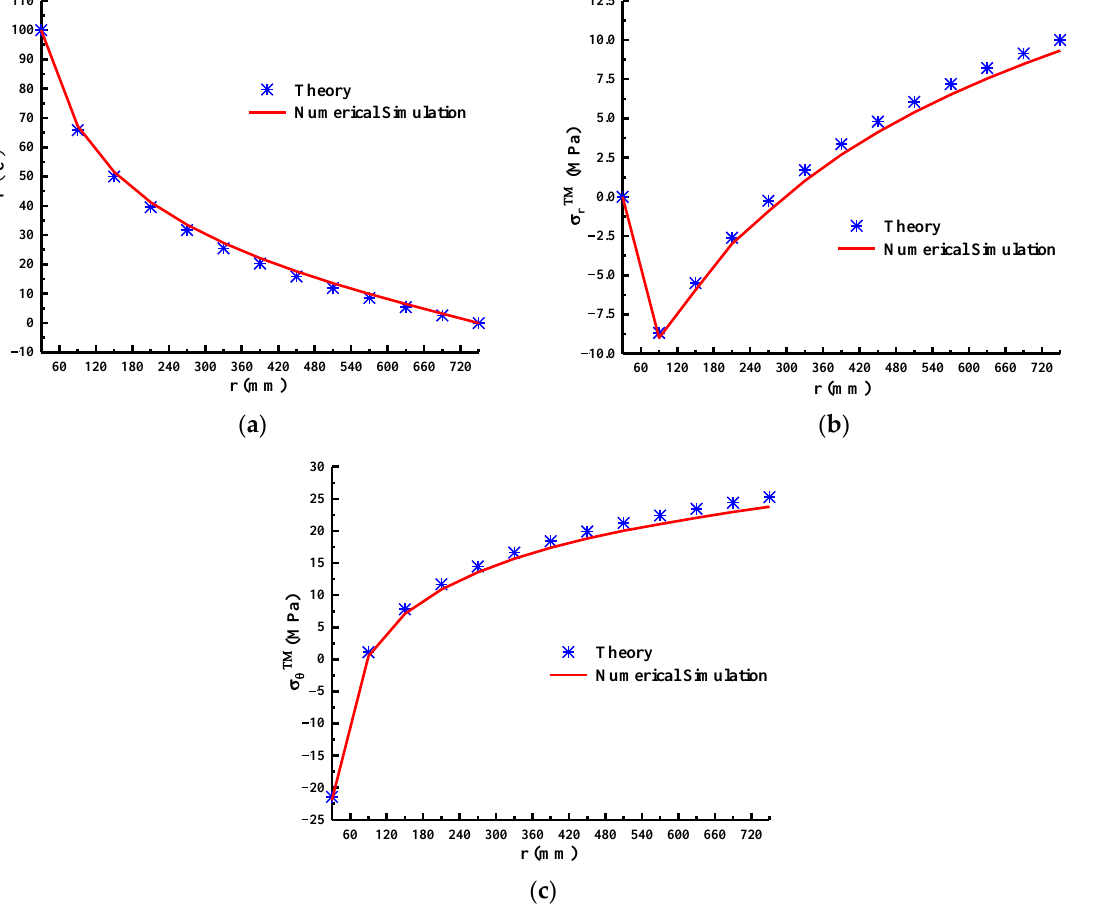
Figure 4. Comparison of the numerical simulation results with the theoretical results. ( a ) The curves of the T when 𝜃 = 0. ( b ) The curves of the 𝜎 𝑟𝑇𝑀 when 𝜃 = 0. ( c ) The curves of the 𝜎 𝜃𝑇𝑀 when 𝜃 = 0.